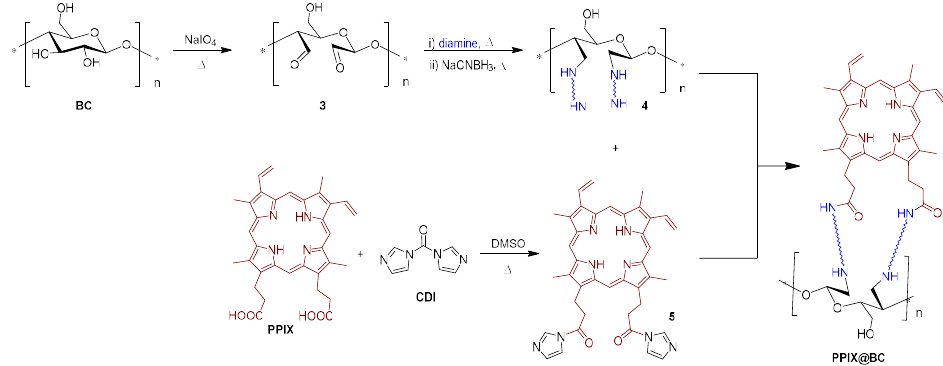
Figure 5. Preparation of PPIX covalently grafted onto a bacterial cellulose surface ( 3 ) via diamine spacer arms with different chain lengths, (adapted from Ref. [138] ).